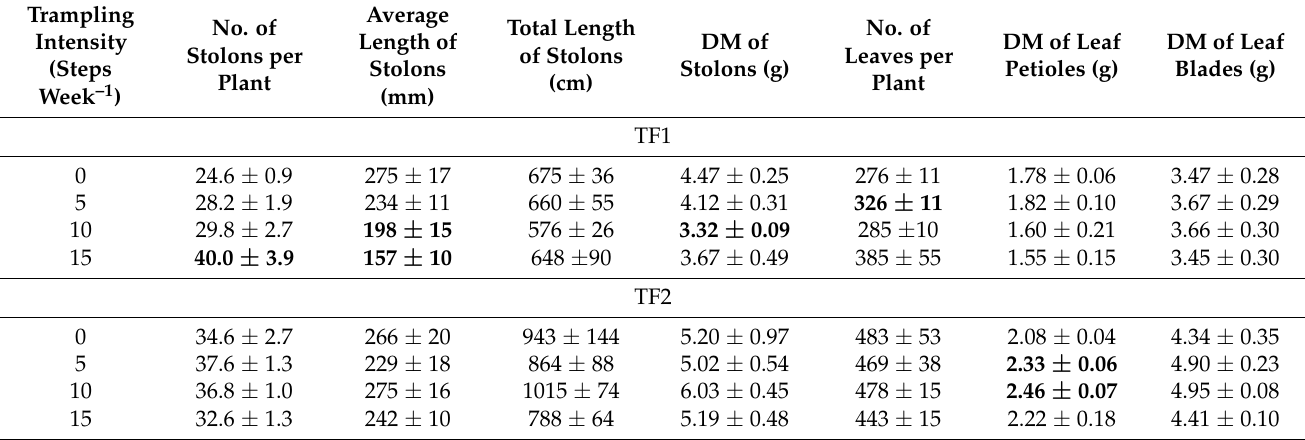
Table 2. Effect of trampling intensity on morphological parameters and dry mass of shoot parts of different Trifolium fragiferum accessions.